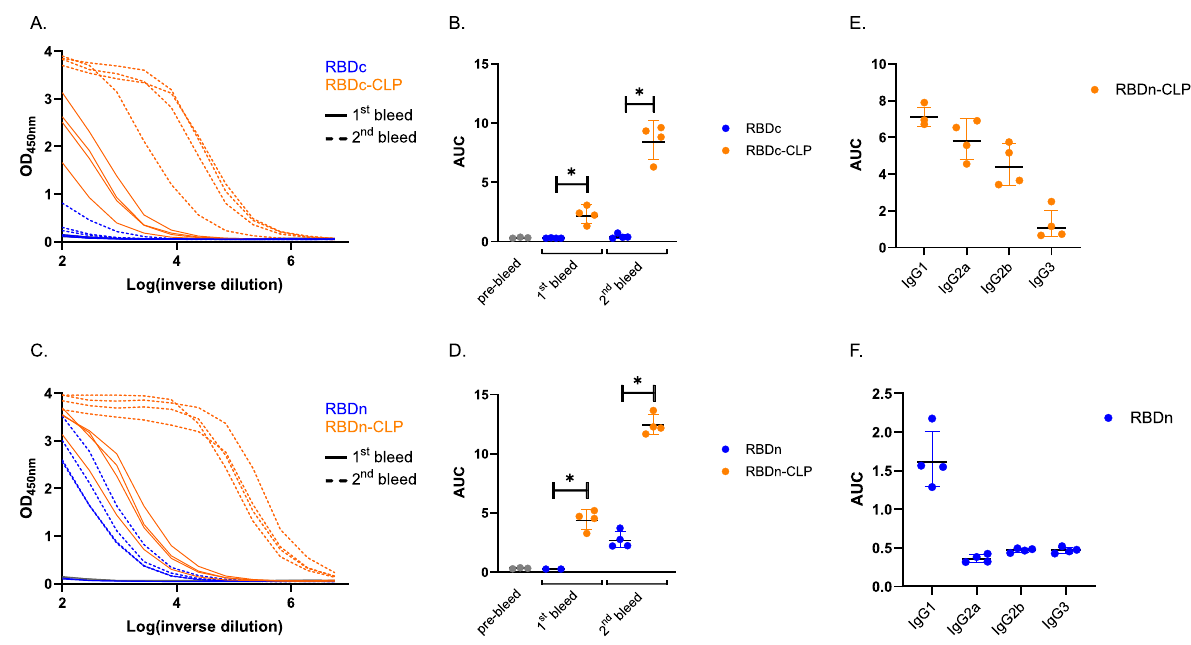
Fig. 4 RBD-CLP vaccines induce high antigen-speci fi c antibody titers in mice. Serum samples were obtained before vaccination (pre-bleed) and two weeks after primary (1st bleed) and boost (2nd bleed) vaccination, respectively. ELISA results are depicted both as raw serum dilution curves ( a , c ) as well as the area under curve (AUC) and the geometric mean/SD ( b , d ). a Serum dilution curves and b geometric mean titer/SD (RBDc 1 st bleed: GMT = 0.289; RBDc 2 nd bleed: GMT = 0.4369; RBDc-CLP 1 st bleed: GMT = 2.252; RBDc-CLP 2 nd bleed: GMT = 8.515) of total anti-SARS-CoV-2 spike (aa35-1227) IgG antibodies detected in sera from BALB/c mice immunized intramuscularly with soluble RBDc (prime 2 µ g/boost 2 µ g) ( n = 4) or CLP-displayed RBDc (RBDc-CLP) (prime 1 µ g/boost 1 µ g) ( n = 4). c Serum dilution curves and d geometric mean titer/SD (RBDn 1 st bleed: GMT = 0.2578; RBDn 2 nd bleed: GMT = 2.727; RBDn-CLP 1 st bleed: GMT = 4.427; RBDn-CLP 2 nd bleed: GMT = 12.44) of total anti-SARS-CoV-2 spike (aa35-1227) IgG antibodies detected in sera from Balb/c mice immunized intramuscularly with soluble RBDn (prime 5 µ g/boost 5 µ g) ( n = 4) or CLP-displayed RBDn (RBDn-CLP) (prime 6.5 µ g/boost <0.1 µ g/boost 6.5 µ g) ( n = 4). e IgG subclass pro fi le in sera from mice ( n = 4) immunized (prime-boost) with the RBDn-CLP vaccine. IgG1 GMT = 7.108; IgG2a GMT = 5.814; IgG2b GMT = 4.390; IgG3 GMT = 1.088. f IgG subclass pro fi le in sera from mice ( n = 4) immunized (prime- boost) with the soluble RBDn vaccine. IgG1 GMT = 1.615; IgG2a GMT = 0.3586; IgG2b GMT = 0.4696; IgG3 GMT =